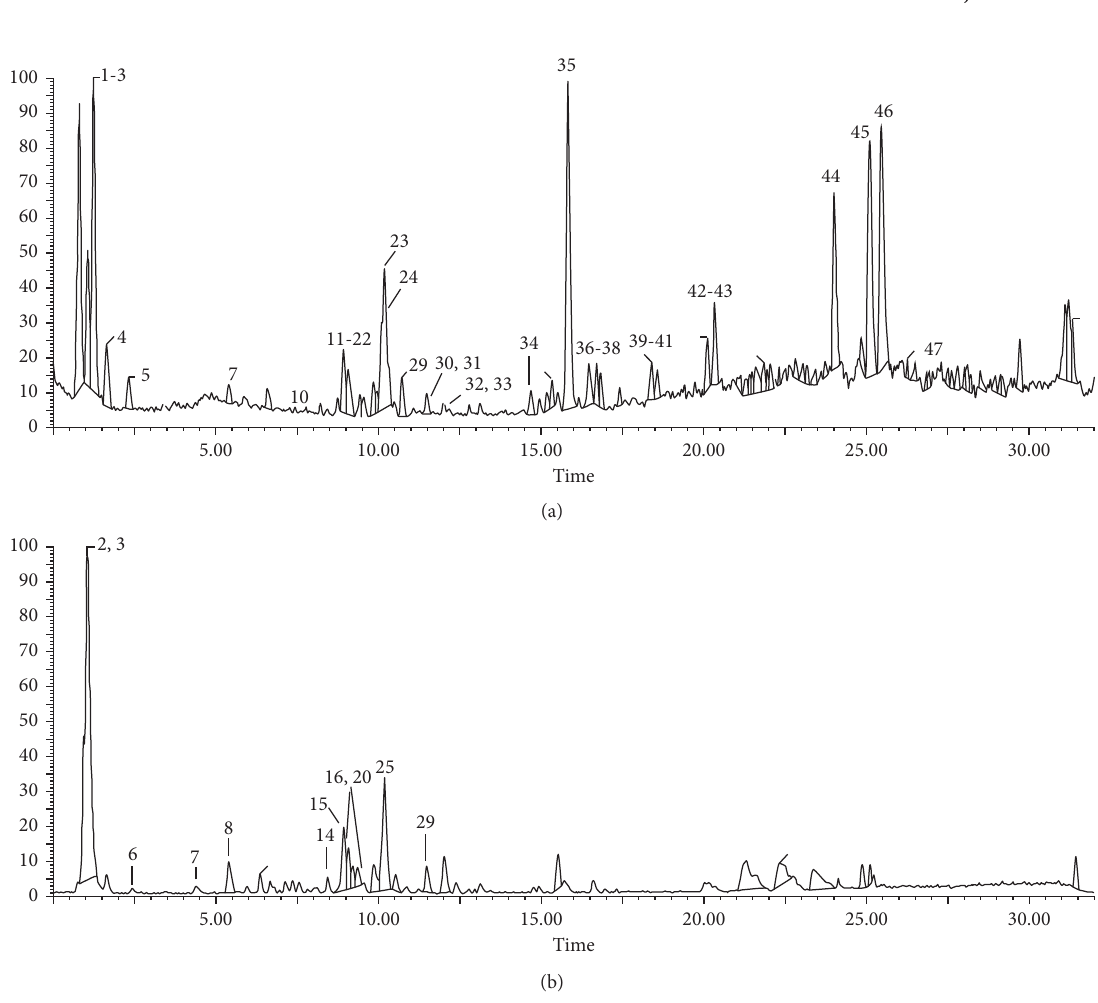
Figure 1: UPLS-ESI-MS chromatograms of E. cardamomum L. aqueous extract: (a) positive ion mode; (b) negative ion mode. Table 1: Tentatively identified metabolites in the aqueous extract of E. cardamomum L. fruits (Card A) using UPLC-ESI-MS in negative and positive ionization